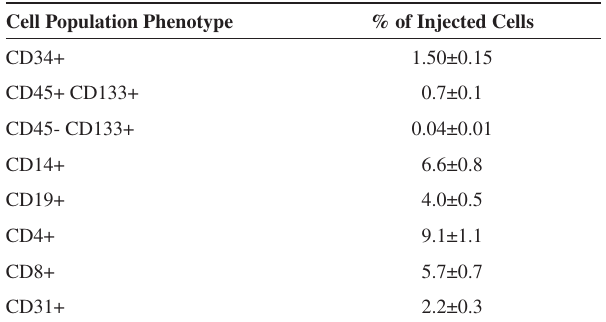
Table 3 - Selected cell populations (%) after flow cytom-